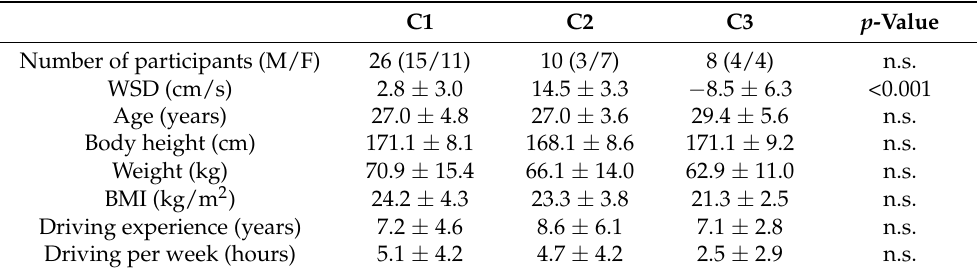
Table 1. Description of personal characteristics and driving experience (data is represented as mean ± standard deviation). C1 C2